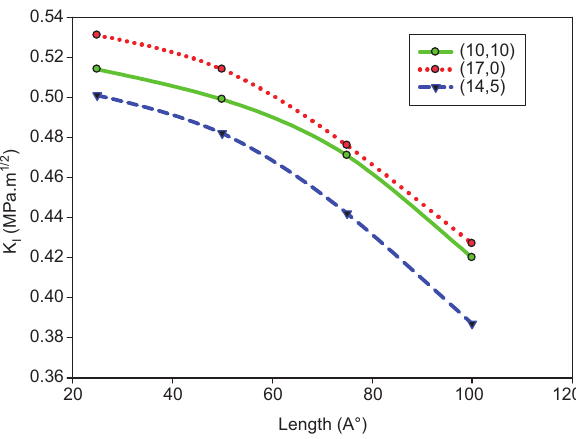
Figure 4 Stress intensity factor of RVEs with (10, 10), (17, 0), (14, 5) nanotubes for length of (25, 50, 75, 100 Å).